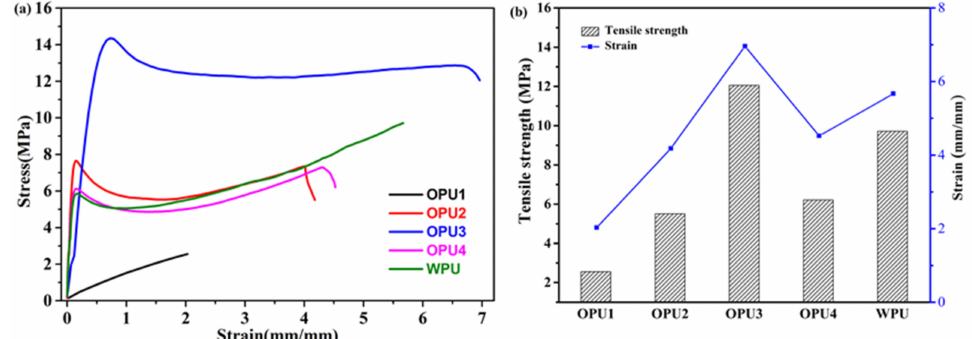
Figure 5. Stress–strain curves of WPU and OPUs ( a ) and the extracted values of tensile strength and stress ( b ).